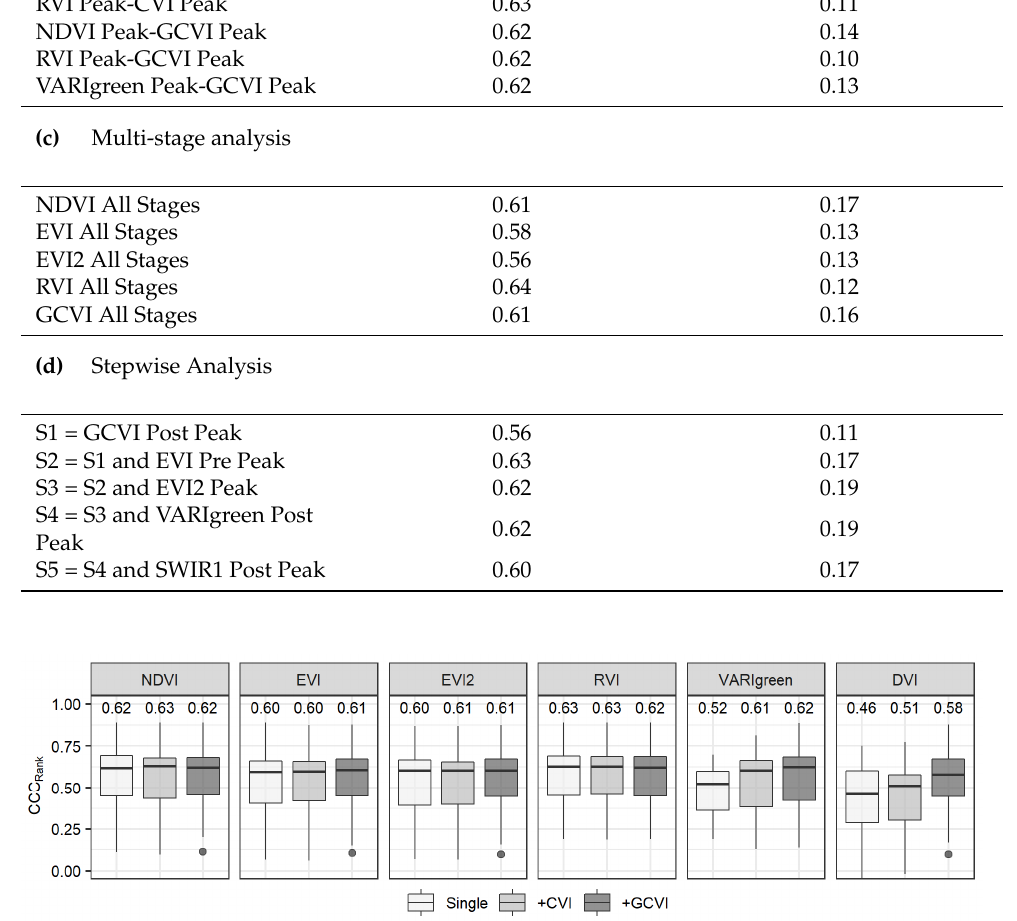
Figure 3. The concordance correlation coefficients of ranks for models with two vegetation indices in the peak stage. Values show the median CCC Rank . For better visualisation, the figure excludes negative CCC Rank.